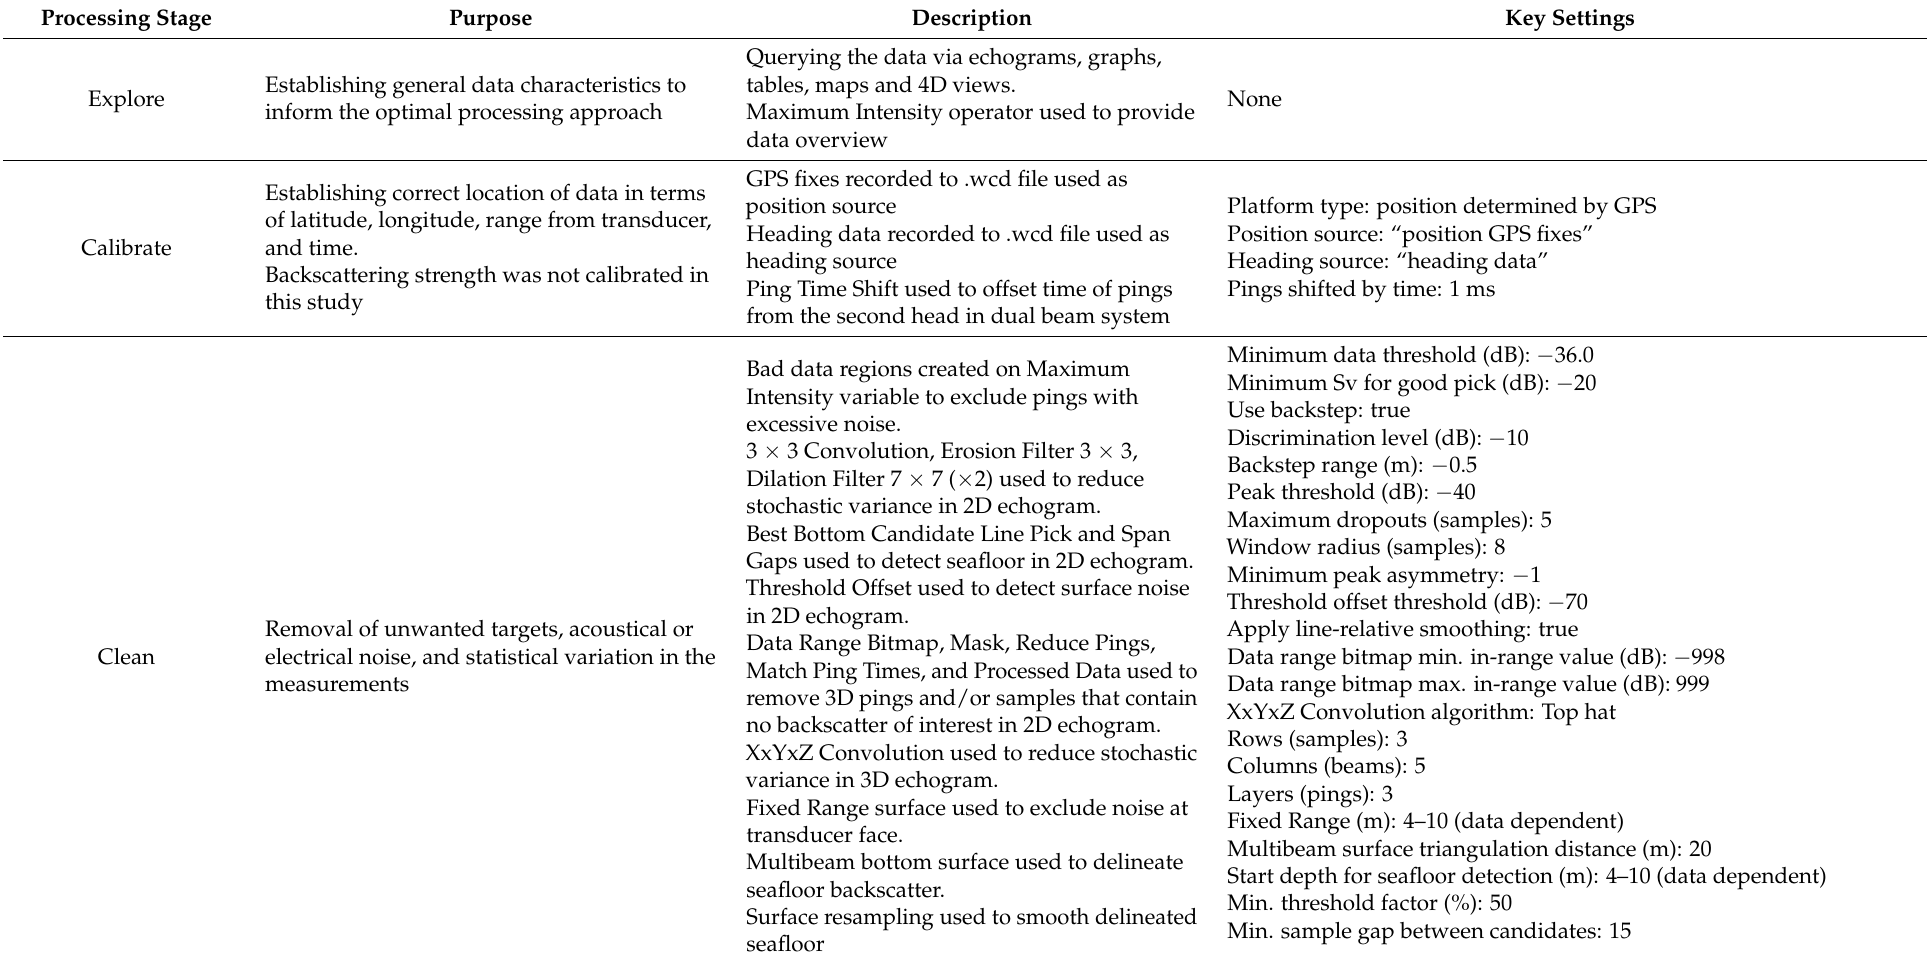
Table A1. Key decision table for the MBES target extraction